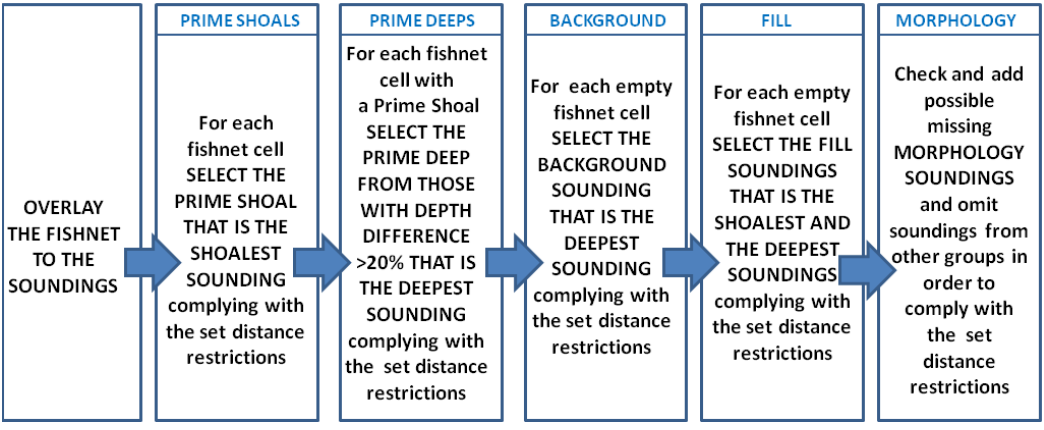
Figure 8. Soundings generalization workflow.